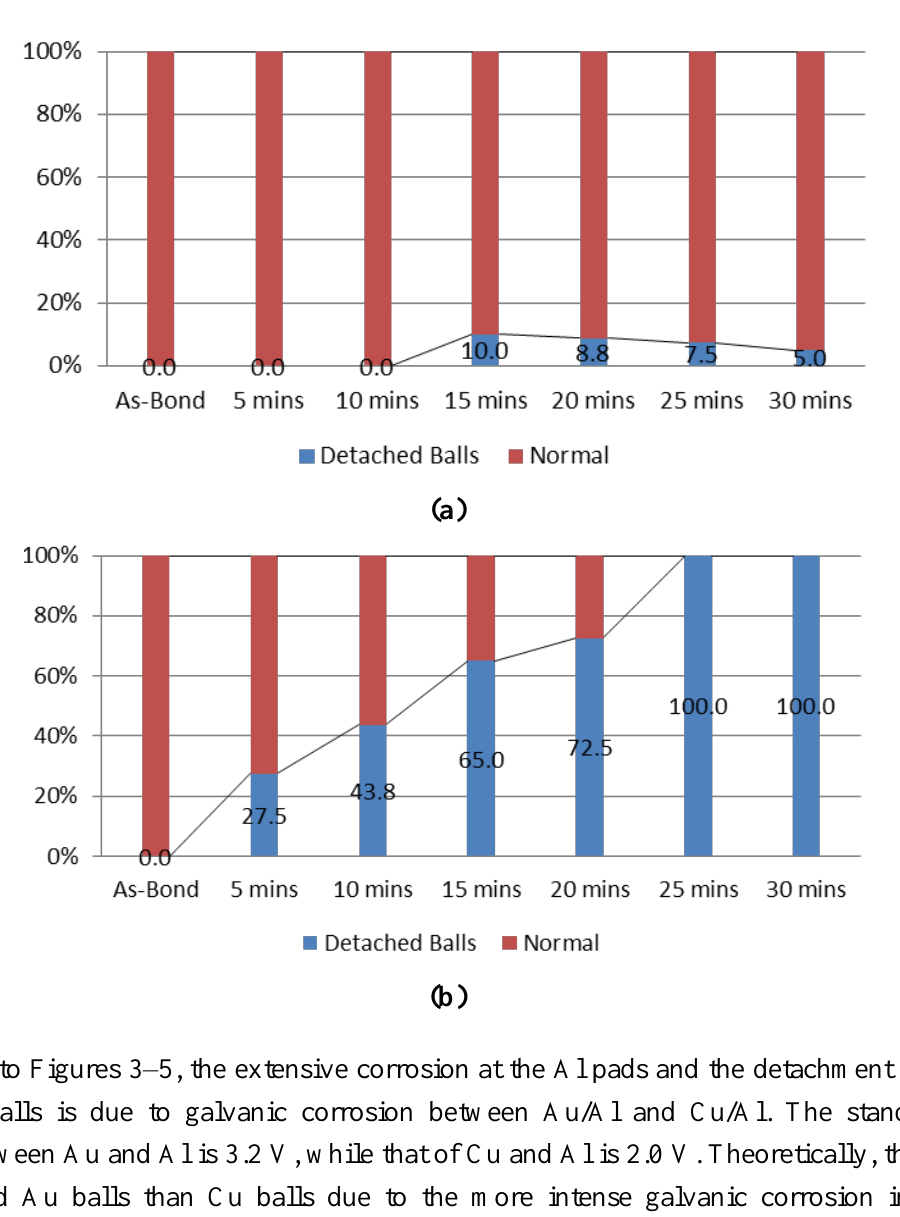
Figure 6. Results on percentage of detached balls on ( a ) Au and ( b ) Cu wire